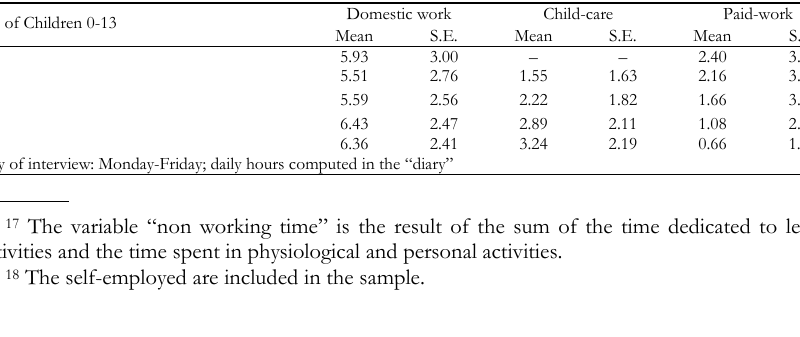
Women’s time allocation by number of children in the family Domestic